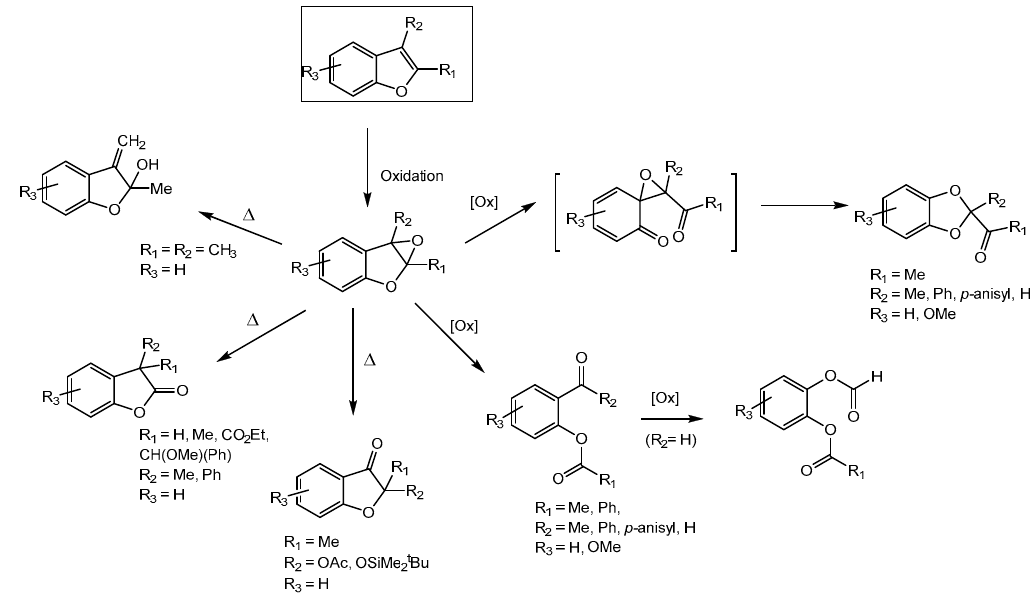
Figure 1. Most common isolated products from the oxidation of substituted benzofurans with m -CPBA or dimethyldioxirane (adapted from [27]).